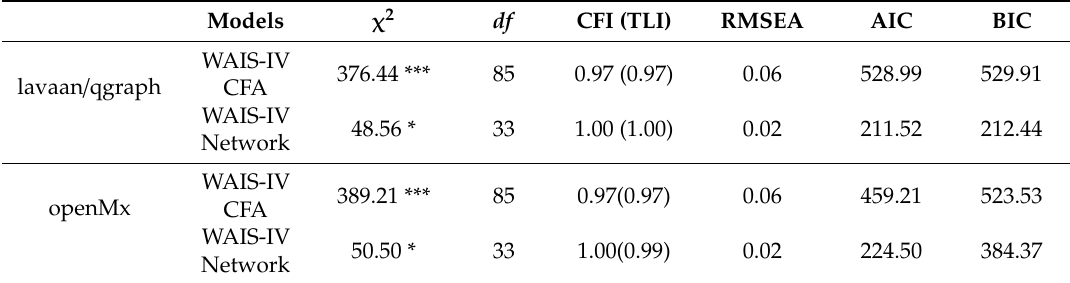
Table 2 . Model Fit Indices for Latent Variable and Network Models of Hungarian Wechsler Adult Intelligence Scale-Fourth Edition Data.